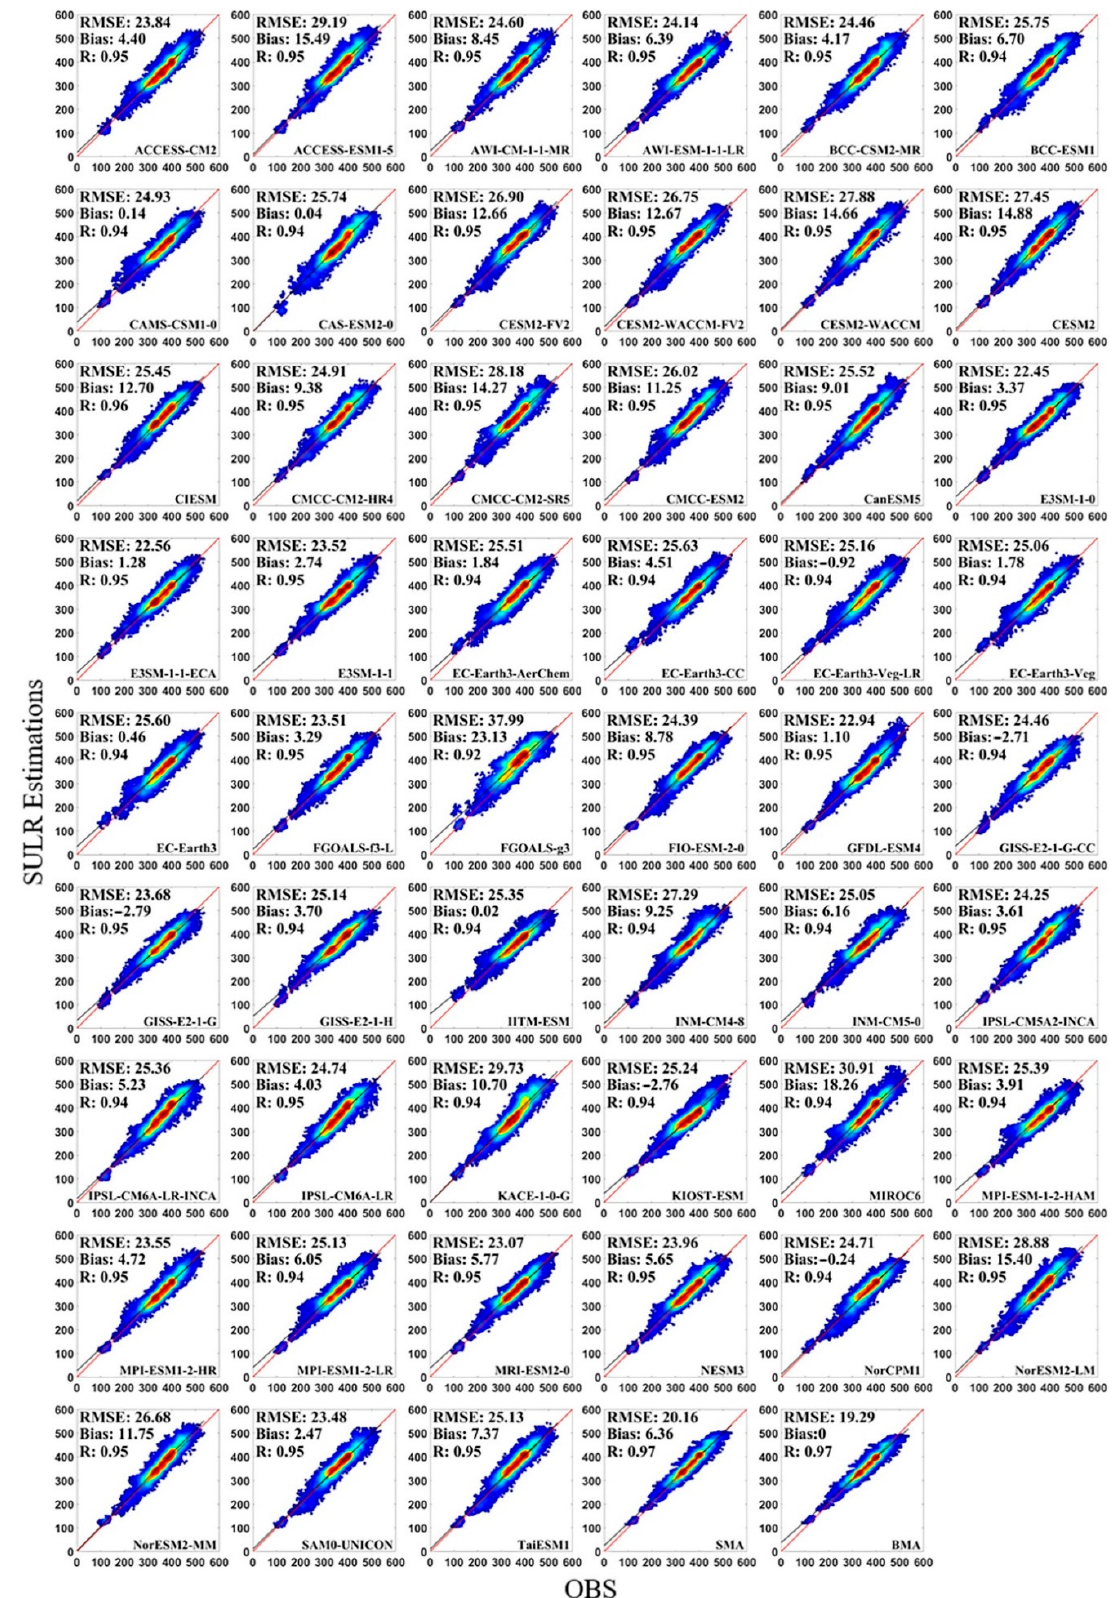
Figure 3. Scatterplots of the monthly SULR observations from 133 sites and the corresponding SULR simulations from the 51 CMIP6 GCMs and the multimodel ensemble (MME) methods (in units of W m − 2 ).